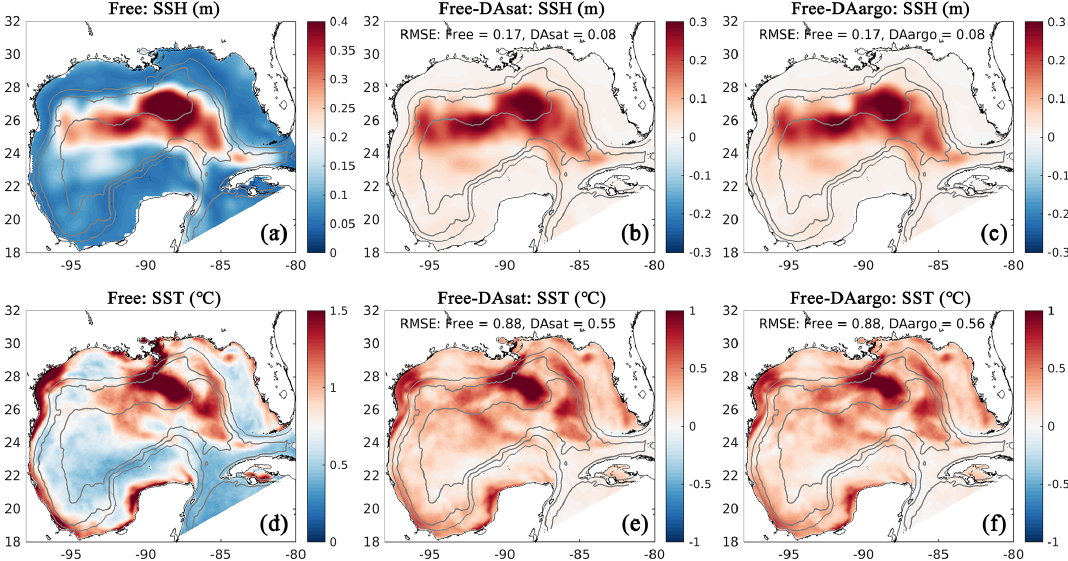
Figure 3. Spatial map of root mean square error (RMSE) in the Free run (a, d) and its differences between the Free run and the two data- assimilative runs for SSH and SST (b, c, e, f) . Positive values represent improvements, while negative values represent deteriorations by data assimilation. Gray contours represent the 300, 1000, and 3000m